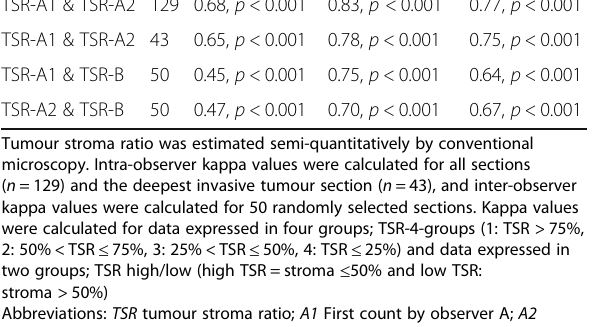
Table 4 Intra-class correlation coefficient (ICC) for tumour budding